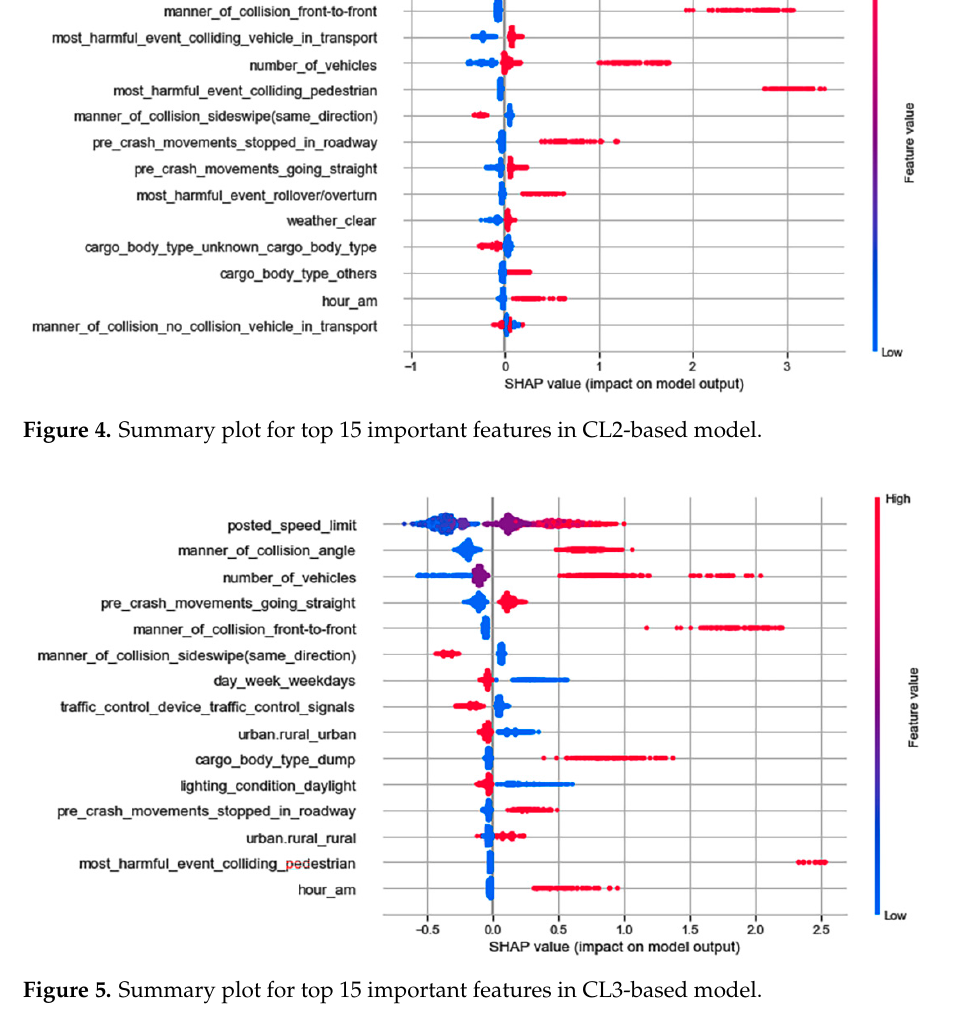
Figure 5. Summary plot for top 15 important features in CL3-based model.